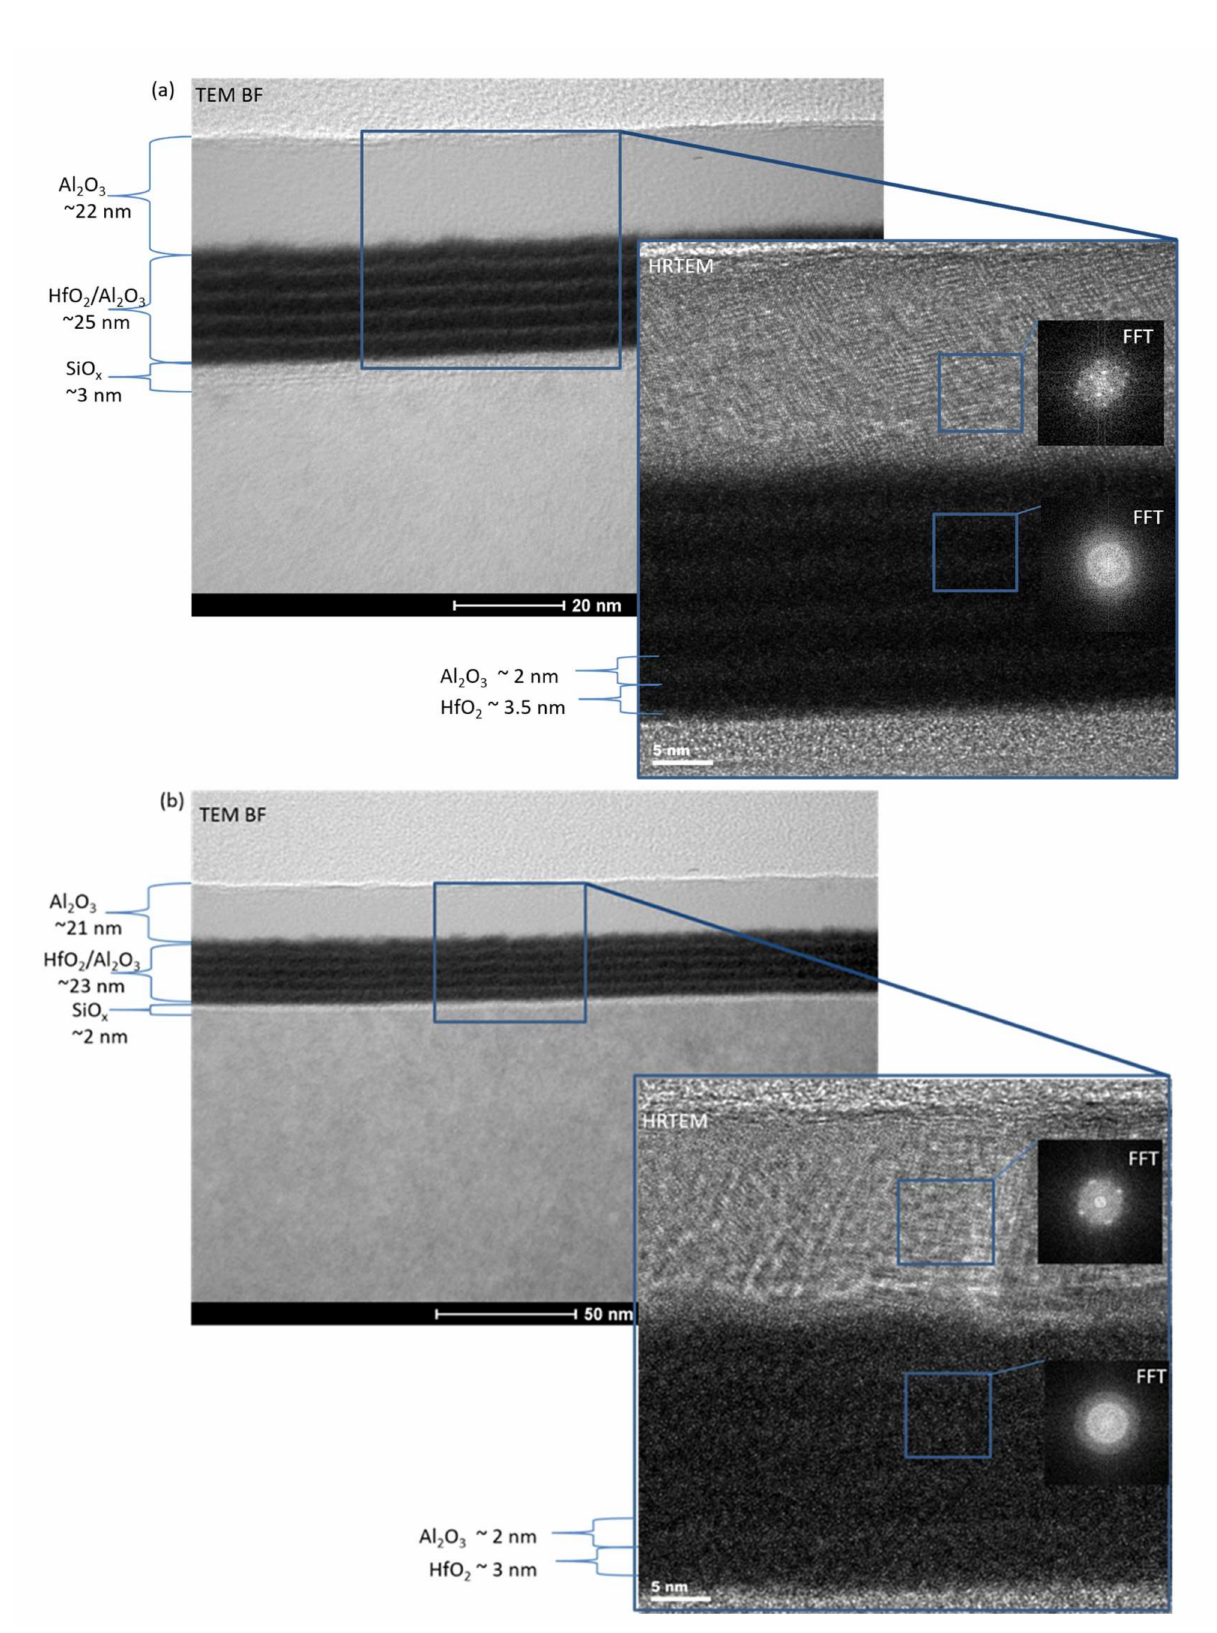
Figure 2. TEM characterization of nanolaminate 5 × (20:5) HfO 2 /Al 2 O 3 high-k dielectric stack with 2.4 nm SiO 2 and BO (Al 2 O 3 ) before ( a ) and after O 2 annealing ( b